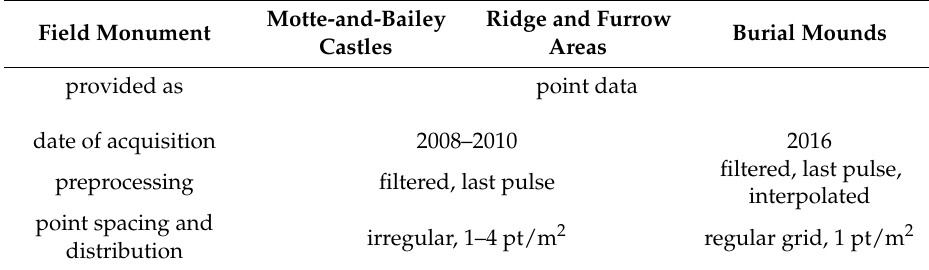
Table 1 . Overview of the LiDAR datasets. Table 1. Overview of the LiDAR datasets.